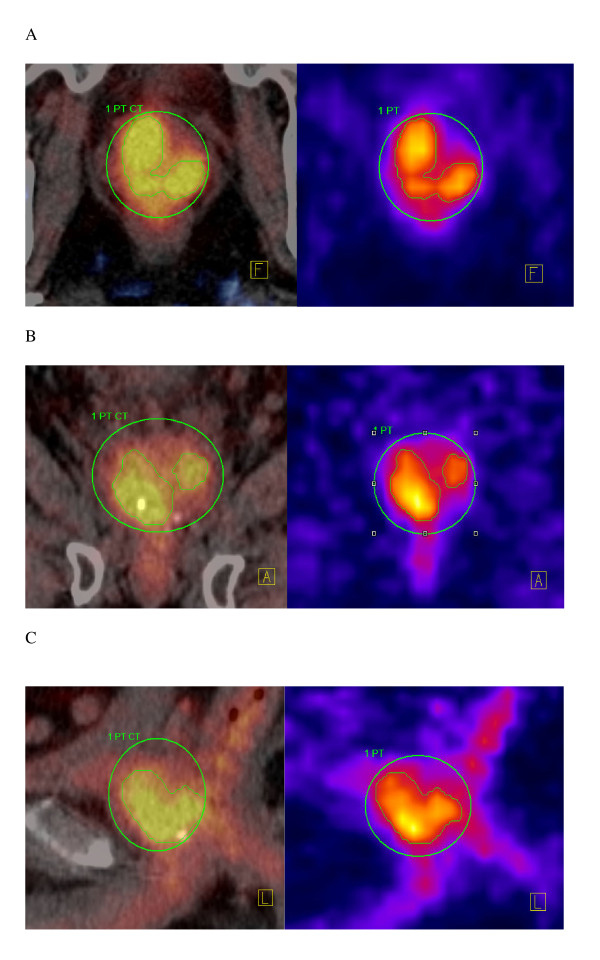
GTV in the axial (A), coronal (B) and sagital (C) simulation CT with PET fusion and 18F-choline PET slice, respectively.